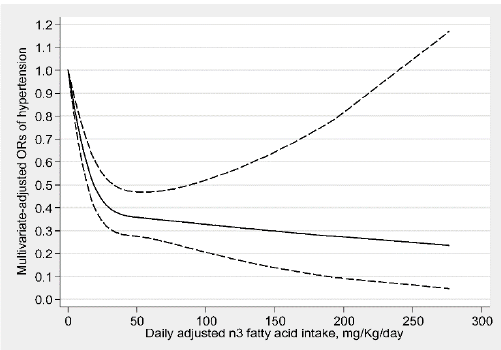
Figure 2. Dose-response relationship between n3 fatty acid intake and hypertension. The association was adjusted for age, gender, race, educational level, income, recreational activity, work activity, drinking status, smoking status, diabetes, and total energy intake. The solid line and dash line represent the estimated ORs and its 95% confidence intervals. (OR, odds ratio).